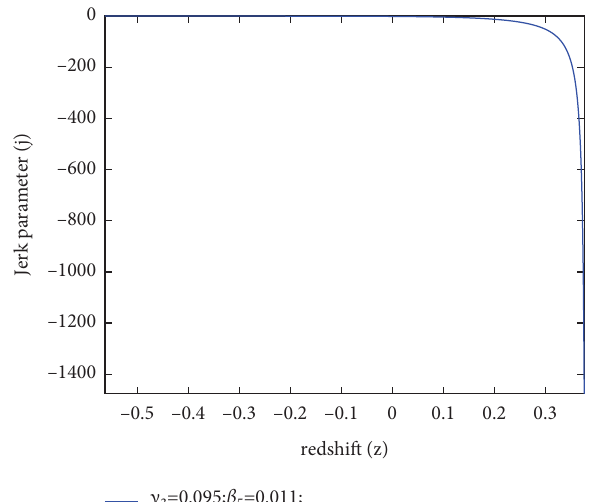
Figure 13: Jerk ( j ) versus redshift ( z ) for BT-IX.